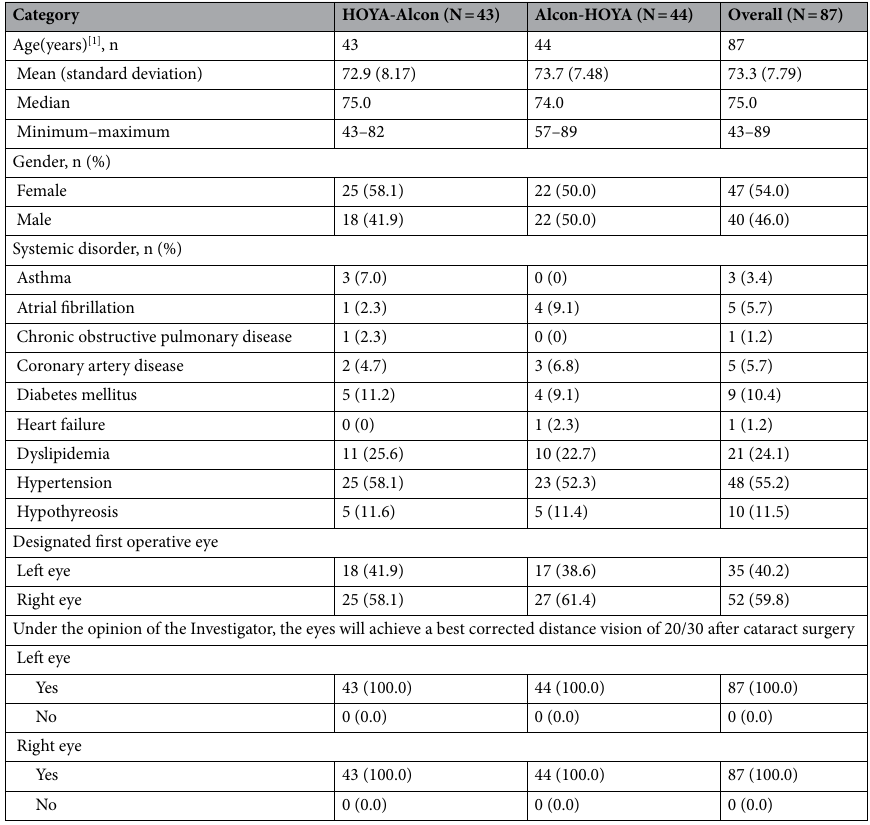
Table 1. Summary of subject demographics and baseline characteristics intent-to-treat population. Percentages are based on the number of subjects in the sequence. [1] Age is the number of full years from date of birth to the date of informed